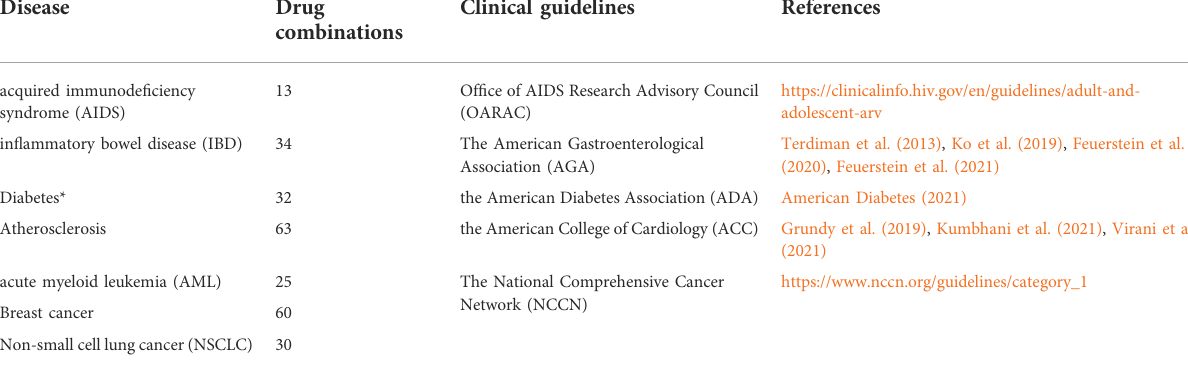
TABLE 3 Disease-speci fi c drug